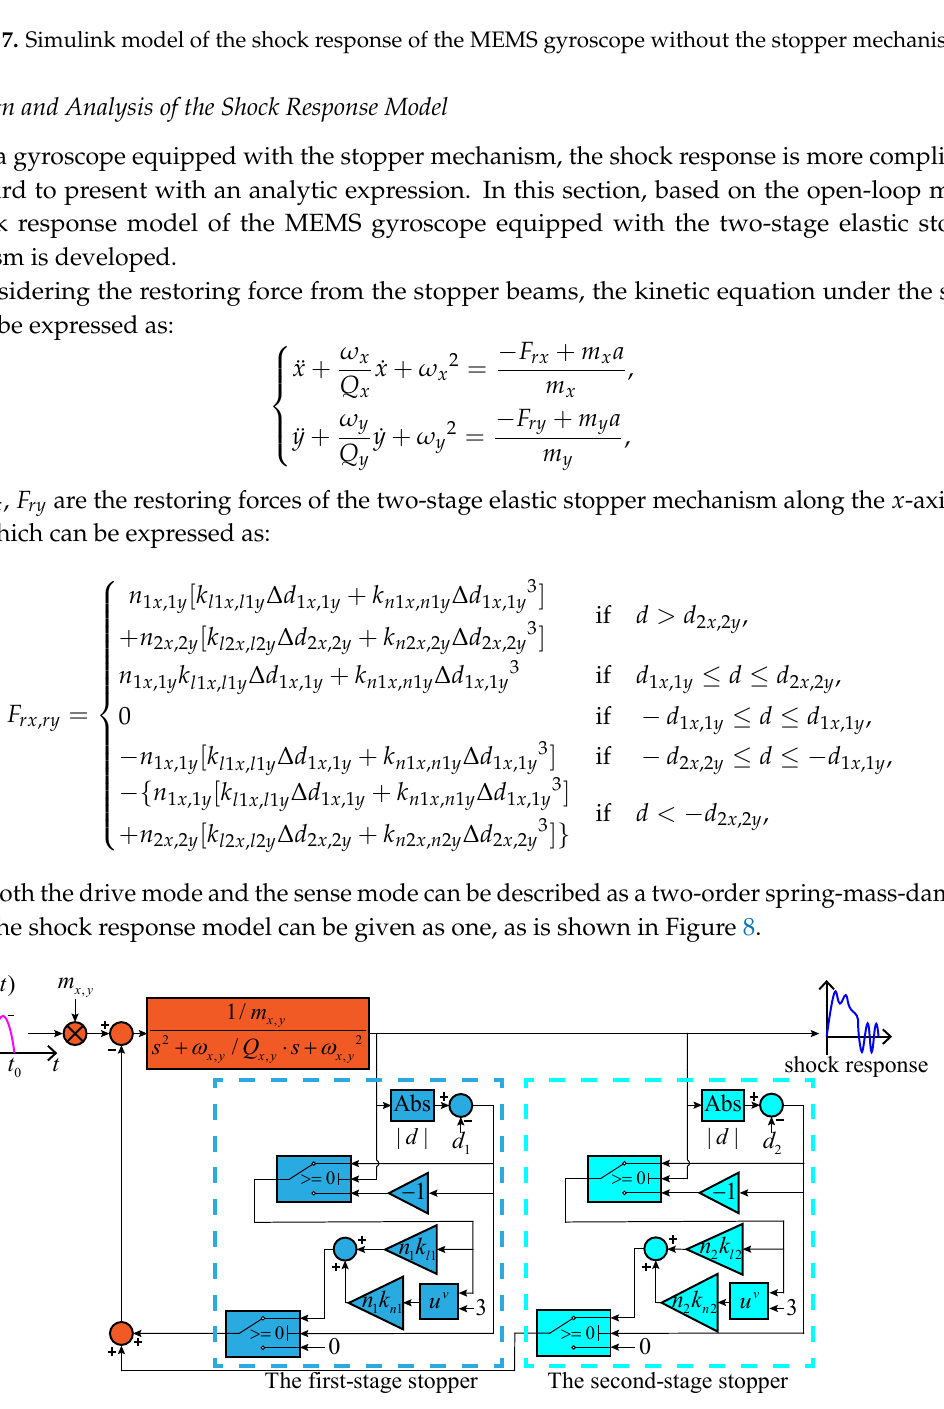
Figure 8. Shock response model of the MEMS gyroscope equipped with the two-stage elastic stopper